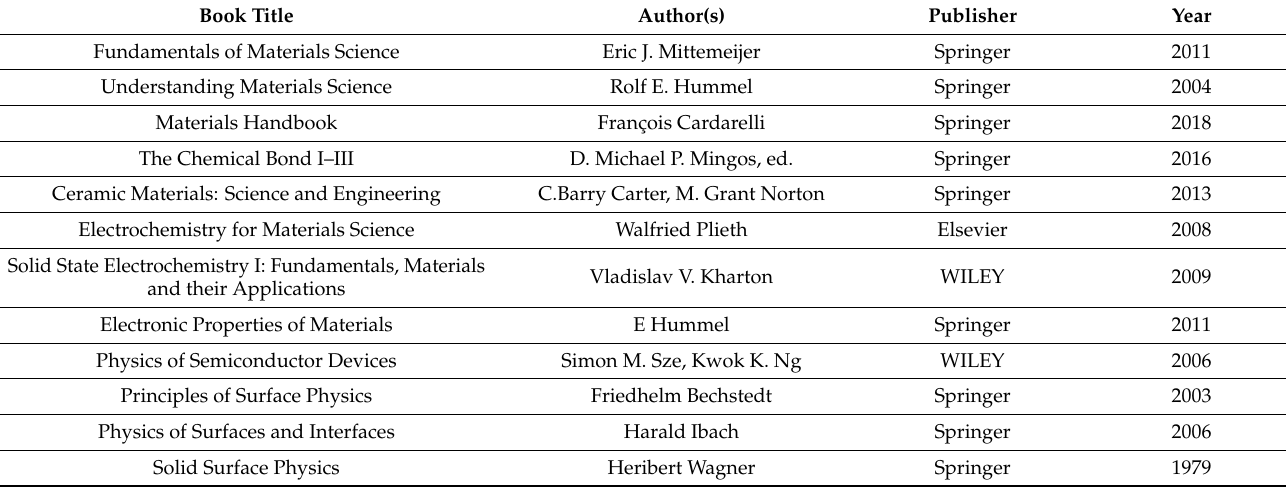
Table 1. List of textbooks used for the prototype